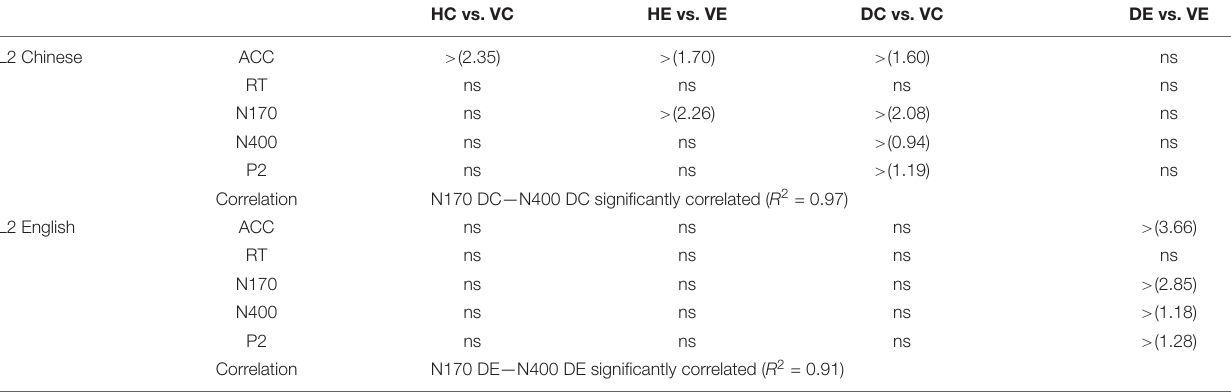
TABLE 3 | Summary table of behavioral and EEG